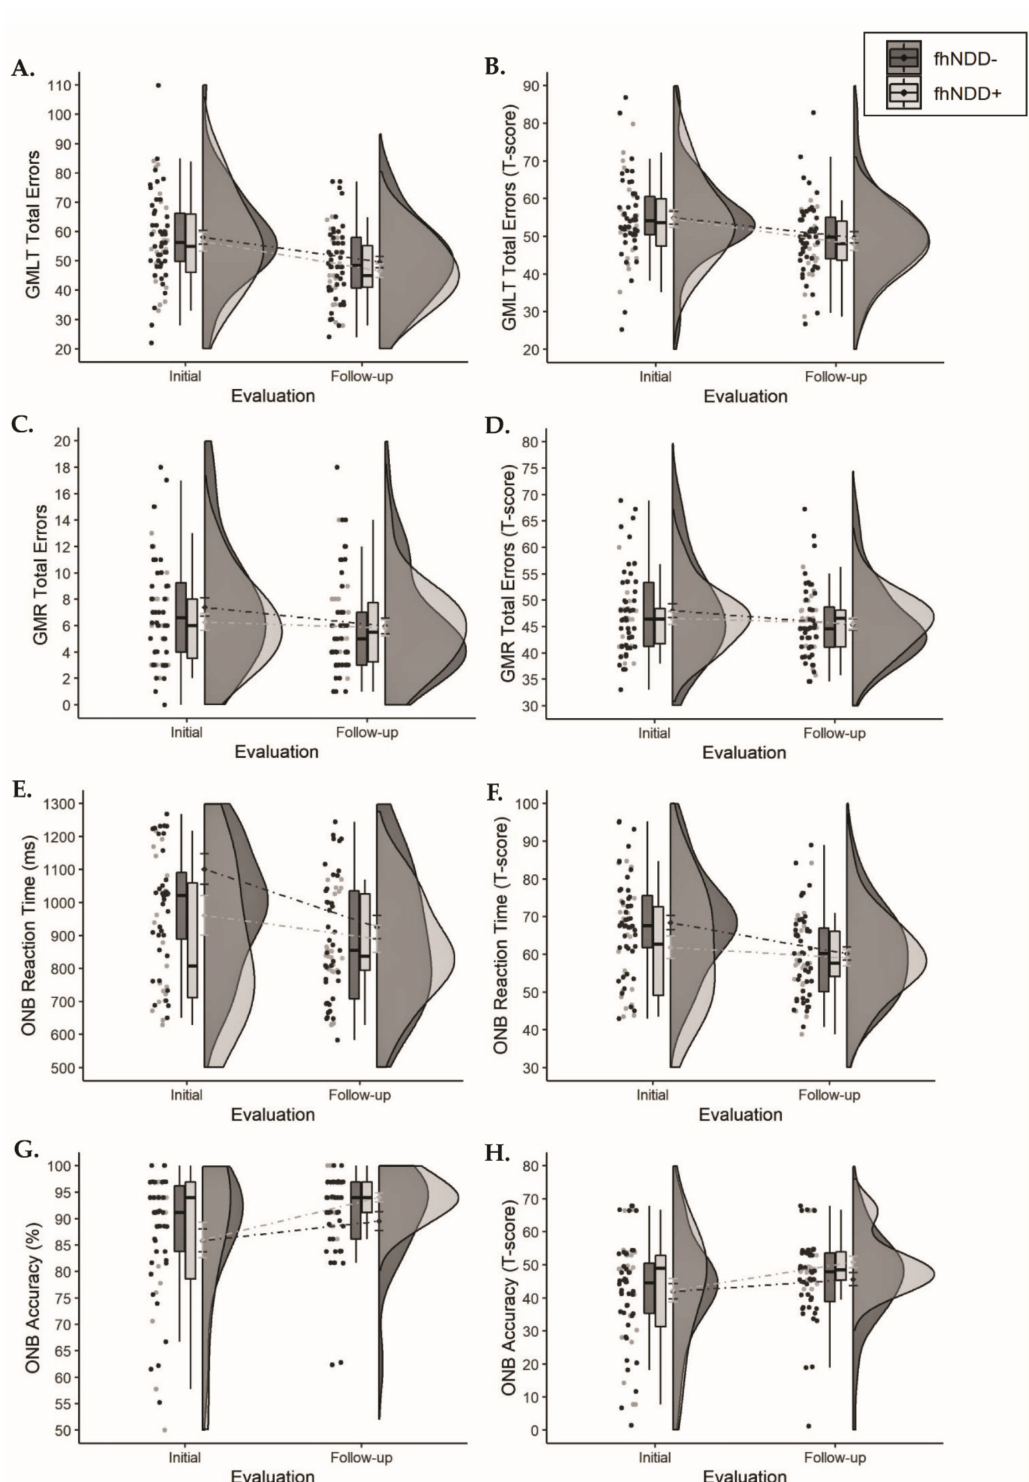
Figure 6. Group comparisons of cognitive performance between those with a family history of neurodegenerative disease (fhNDD+; light gray) and without a family history of neurodegenerative disease (fhNDD − ; dark gray). ( A ) GMLT total errors. ( B ) GMLT total errors t -score. ( C ) GMR total errors. ( D ) GMR total errors t -scores. ( E ) ONB reaction time (ms). ( F ) ONB reaction time t -score. ( G ) ONB accuracy (%). ( H ) ONB accuracy t